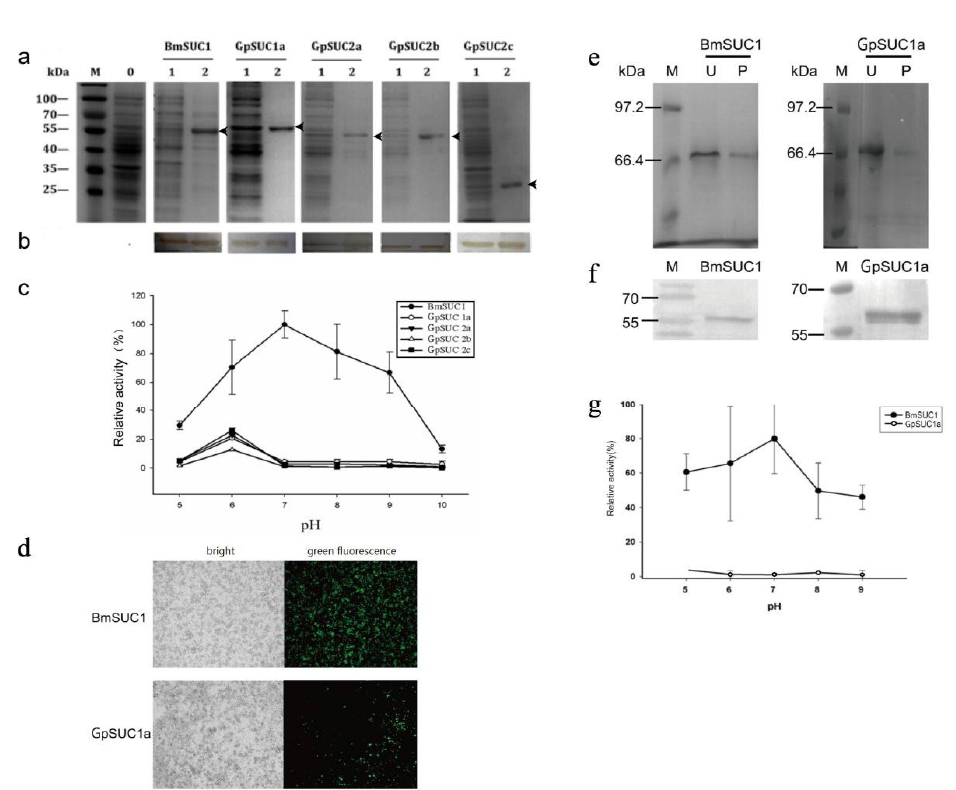
Figure 2. Expression of recombinant proteins in vitro. SDS-PAGE ( a ) and western blot ( b ) were used to analyze the recombinant proteins. Lanes 0: empty pET-24b vector, Lanes 1 total protein